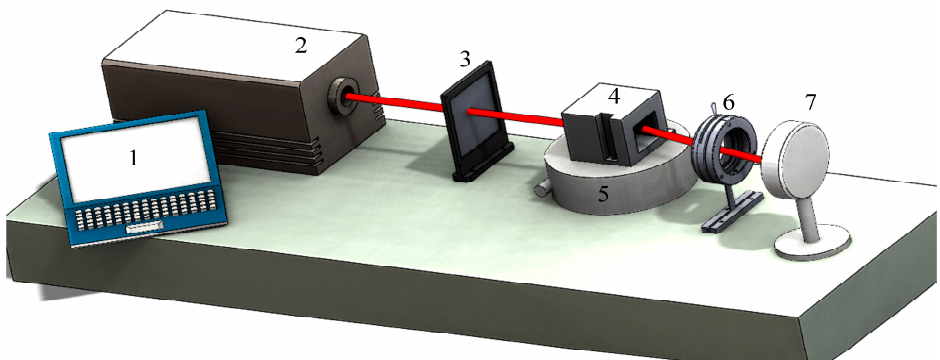
Figure 5. The schematic diagram of AOTF geometric parameter calibration. 1—computer; 2—mid ‐ infrared laser; 3—polarizer; 4—AOTF; 5—precision turntable; 6—diaphragm; 7—optical power me ‐ ter.